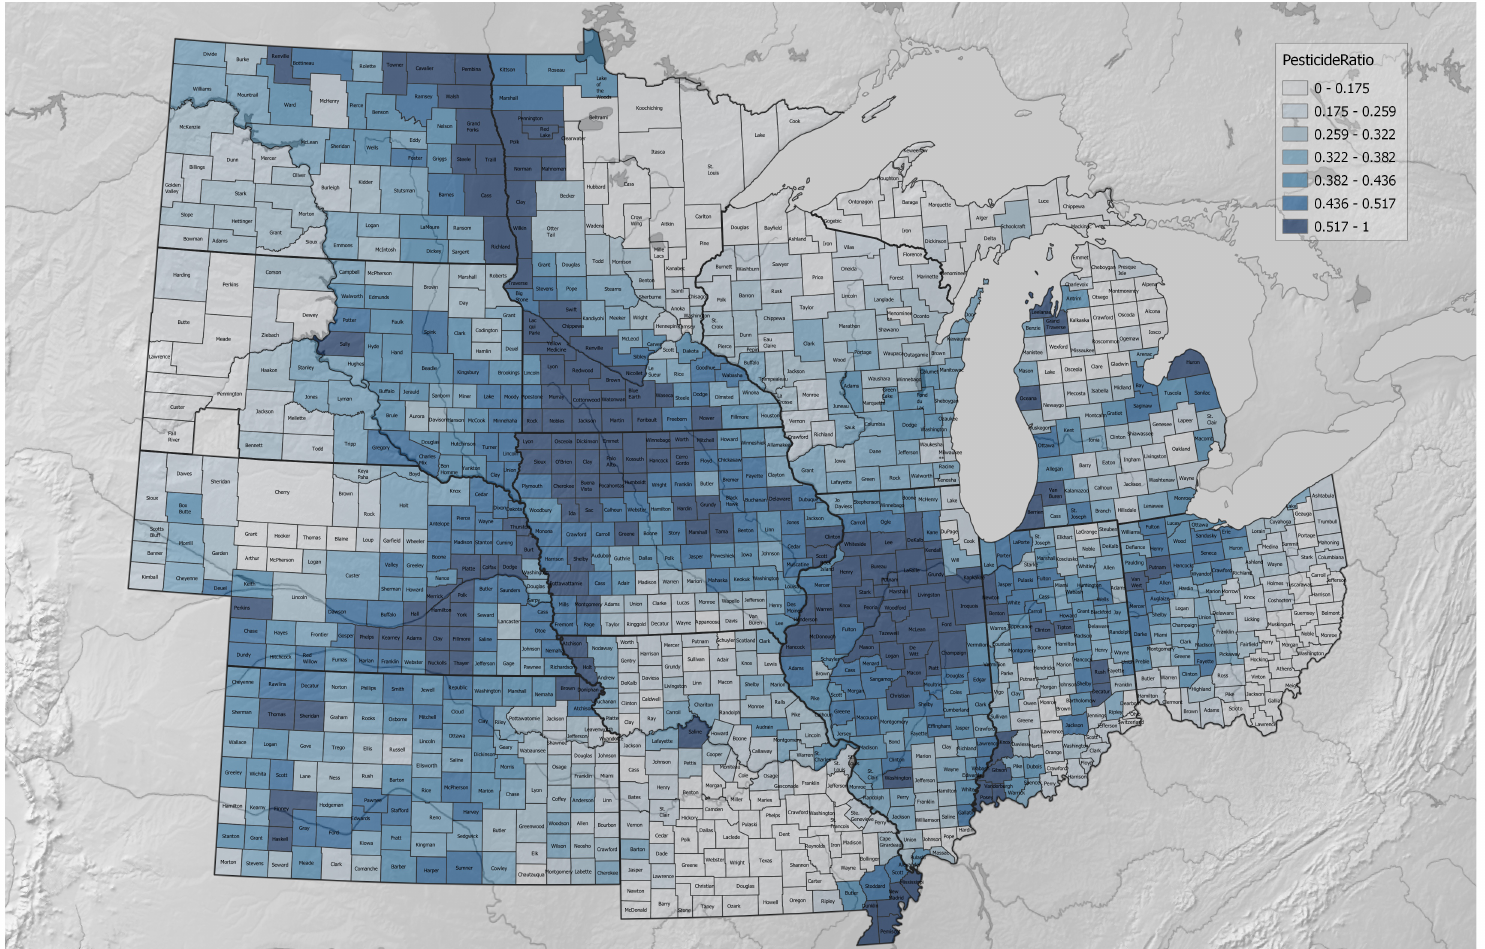
Figure A10. Number of types of pesticides applied by the average farm, by county, 2017. Values were all rescaled through dividing by the largest value present for any of the counties included here (2.174 in Pemiscot County, Missouri), as this transformation was applied to the variable data as they were placed into the index expression. Methods for PesticideRatio are described in the article main text and Supplementary Materials. USDA 2017 Census of Agriculture data [52] were